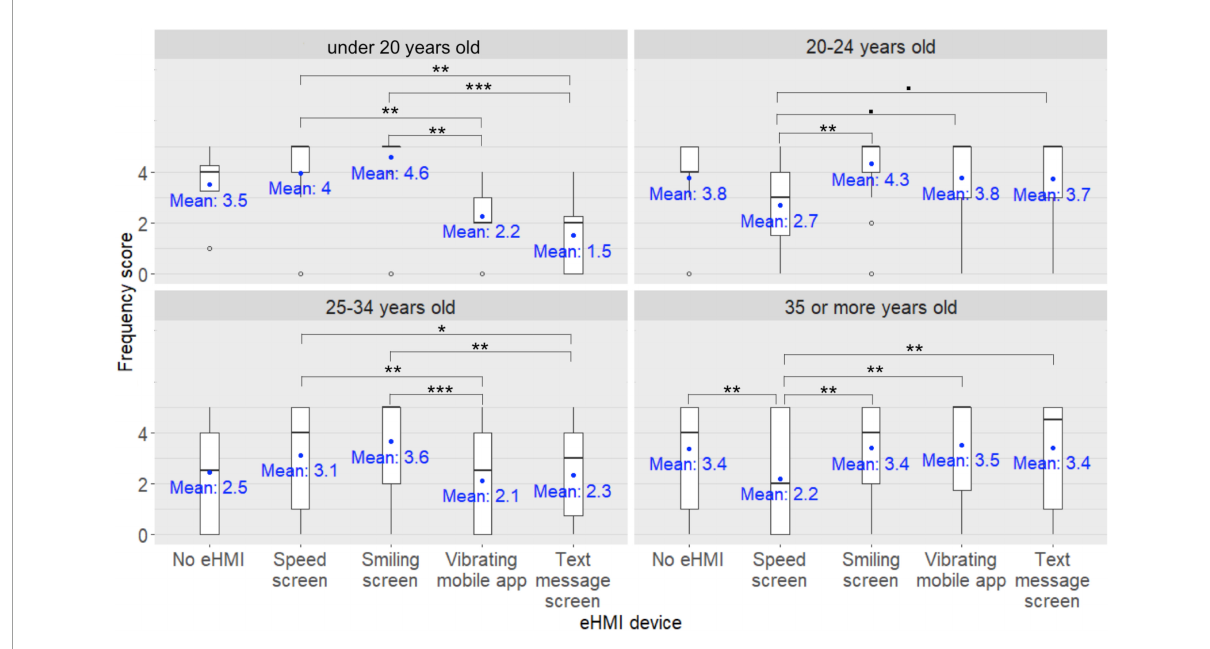
FIGURE8 External Human-Machine Interface (eHMI) × participants’ age group interaction on the kick scooter users’ frequency scores for seeking eye contact with the human driver of the approaching car in order to express their willingness to cross to the human driver • : pFDR < 0.10, *: pFDR < 0.05, **: pFDR < 0.01, ***: pFDR <